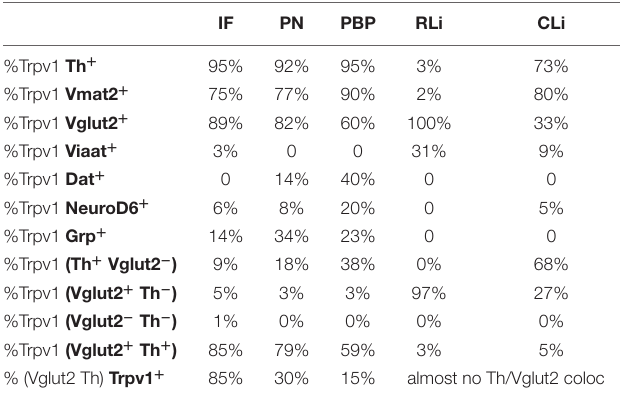
TABLE 1 | TrpV1mRNA and its extent of co-localization with a range of neurotransmitter and neuronal subtype markers. Characterisation of Trpv1 mRNA-positive phenotype in VTA subnuclei